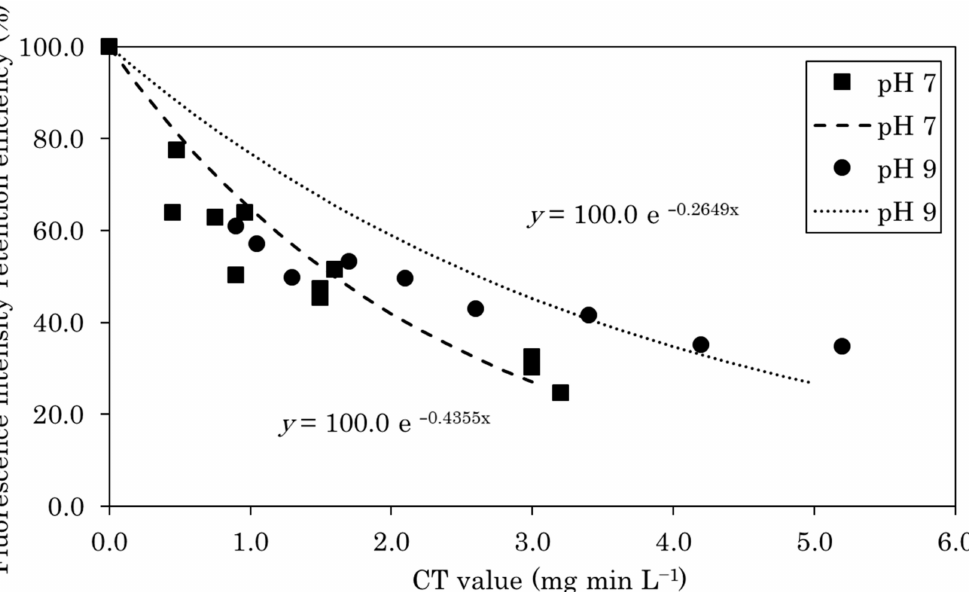
Figure 1. Fluorescence intensity retention e ffi ciencies during chlorination at pH 7 and 9 plotted as functions of CT value. The fluorescence intensity reduction curve was calculated from the first-order decay